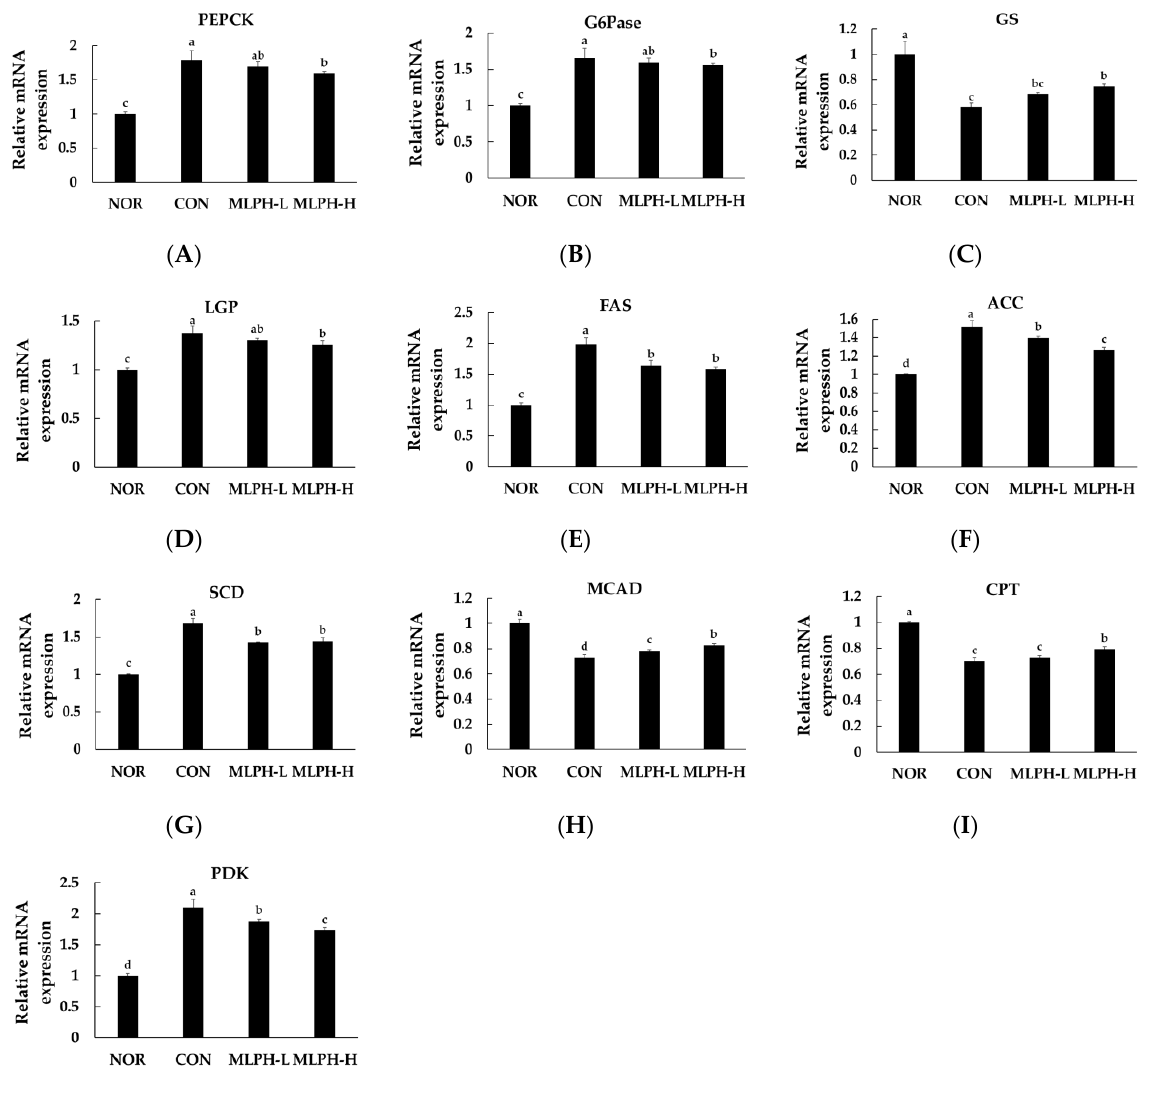
Figure 7. Effects of MLPH on mRNA expression of lipid and glucose metabolism related genes: ( A ) phosphoenolpyruvate carboxykinase (PEPCK), ( B ) G6Pase, ( C ) glycogen synthase (GS), ( D ) liver glycogen phosphorylase (LGP), ( E ) fatty acid synthase (FAS), ( F ) acetyl-CoA carboxylase (ACC), ( G ) stearoyl-CoA desaturase (SCD), ( H ) medium chain acyl-CoA dehydrogenase (MCAD), ( I ) carnitine palmitoyltransferase (CPT), and ( J ) pyruvate dehydrogenase kinase (PDK). Each value represents the mean ± SEM ( n = 6). a–c Values not sharing a common letter are significantly different at p < 0.05 by Tukey’s multiple comparison